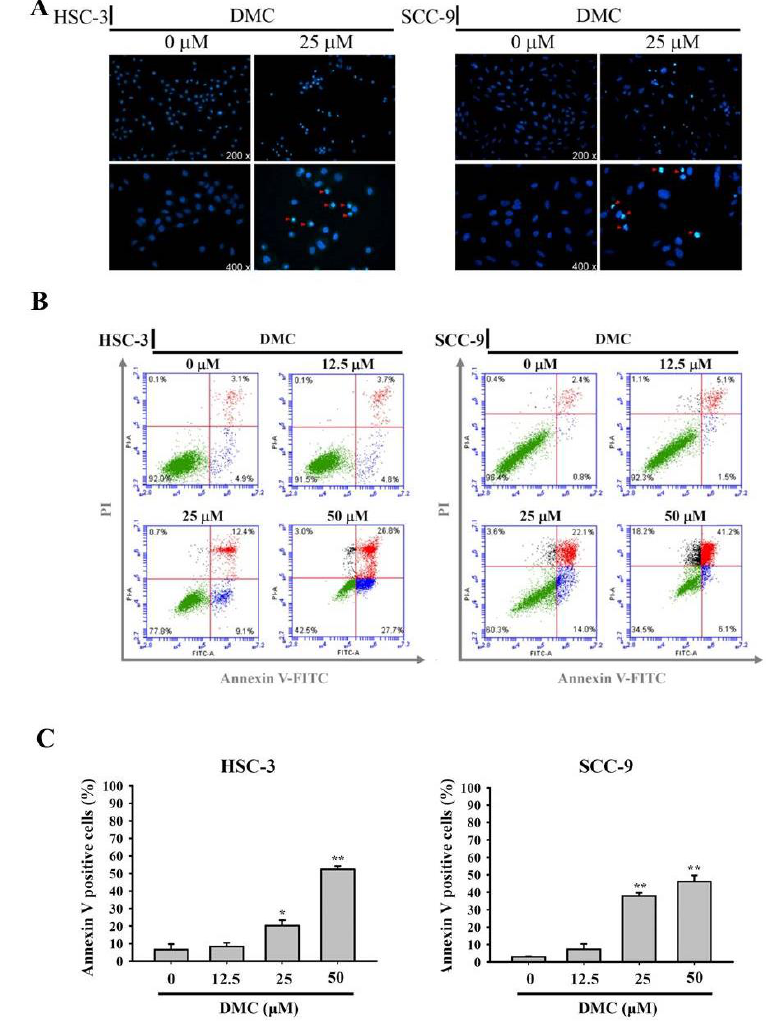
Figure 2. Demethoxycurcumin (DMC) induces apoptotic cell death in oral squamous cell carcinoma (OSCC) cells. ( A ) After 24 h DMC (25 μM) treatment of SCC-9 and HSC-3 cells, the morphological characteristics of apoptosis were analyzed by fluorescence microscopy after Hoechst 33342